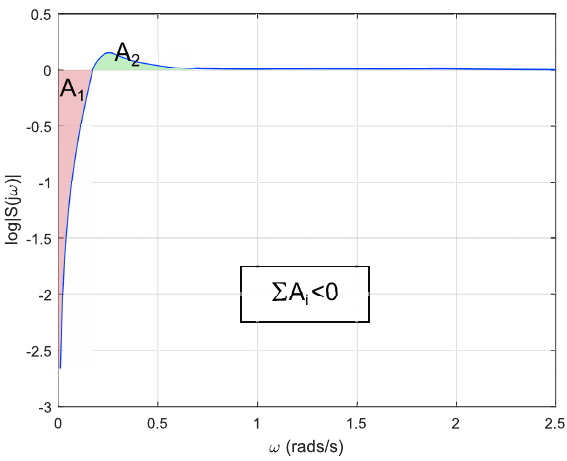
Figure 19. Sensitivity function of a reset